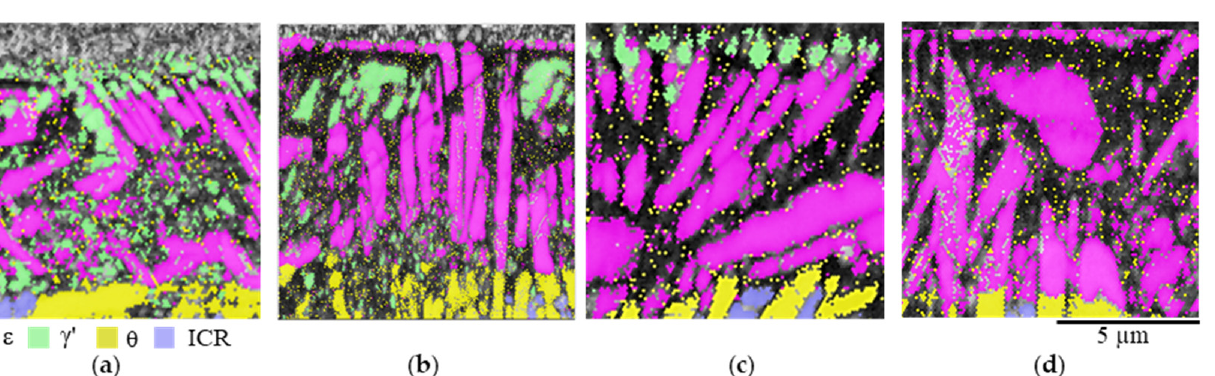
Figure 8. Cross-sectional EBSD phase maps of the compound layers formed after nitriding (540 °C, 16 h) with ( a , c ) K N = 1 atm − 1/2 and ( b , d ) K N = 4 atm − 1/2 on cast iron alloys: ( a , b ) T-2.2Si-0.1Mn-0.7Cu with Cu, and ( c , d ) T-2.5Si-0.2Mn-0.1Cu with hardly any Cu (individual yellow dots in the compound layer: mis-indexed cementite pixels).